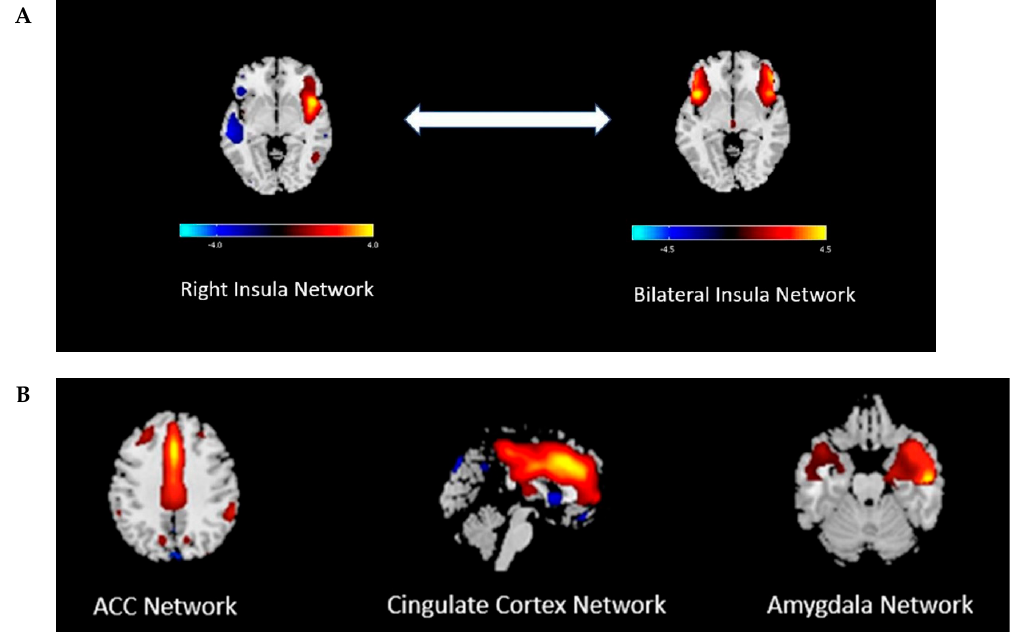
Figure 3. ( A ) Central nervous system mechanisms of nausea in patients with gastroparesis depicted by functional magnetic resonance imaging (fMRI) brain images (bidirectional arrow). The first image is described as the “Right Insula Network” and it depicts maximal values in the right insula that extend into the left temporal lobe. The second image contains both the right and left insula and is described as “Bilateral Insula Network” and it represents comparison after exposure to a nausea-inducing visual stimulus in 10 gastroparetics and 8 healthy controls. The functional network connectivity was significantly reduced ( p < 0.001) in gastroparetic patients versus healthy controls after visual stimulation between the right insula network and bilateral insula network. The highlighted areas illustrate the locations of reduced connectivity in gastroparesis. ( B ) These fMRI images depicting the anterior cingulate cortex, cingulate cortex, and amygdala networks were compared for functional network connectivity differences in the 10 gastroparetic patients versus 8 healthy controls at baseline and after visual stimulation. These three networks did not show significant functional network connectivity differences after induction of nausea between the gastroparetic patients and healthy controls. Reprinted by permission from Nature/Springer. Copyright 2020. symptoms, microstructural changes were detected using diffusion weighted MRI in areas of the brain involved with visceral sensory processing [33]. The brain changes in some areas correlated with